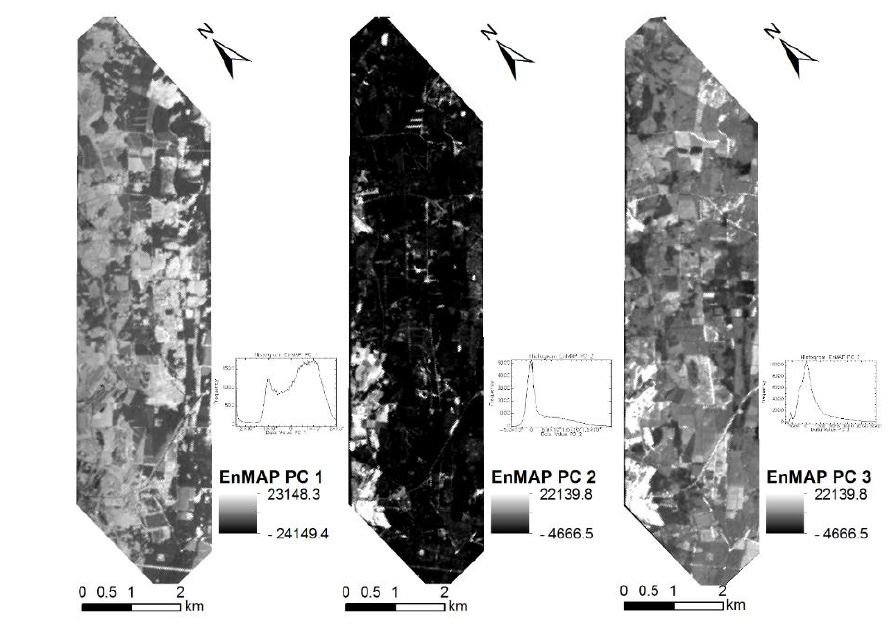
Figure 5. Images of the first three principal components of EnMAP data.